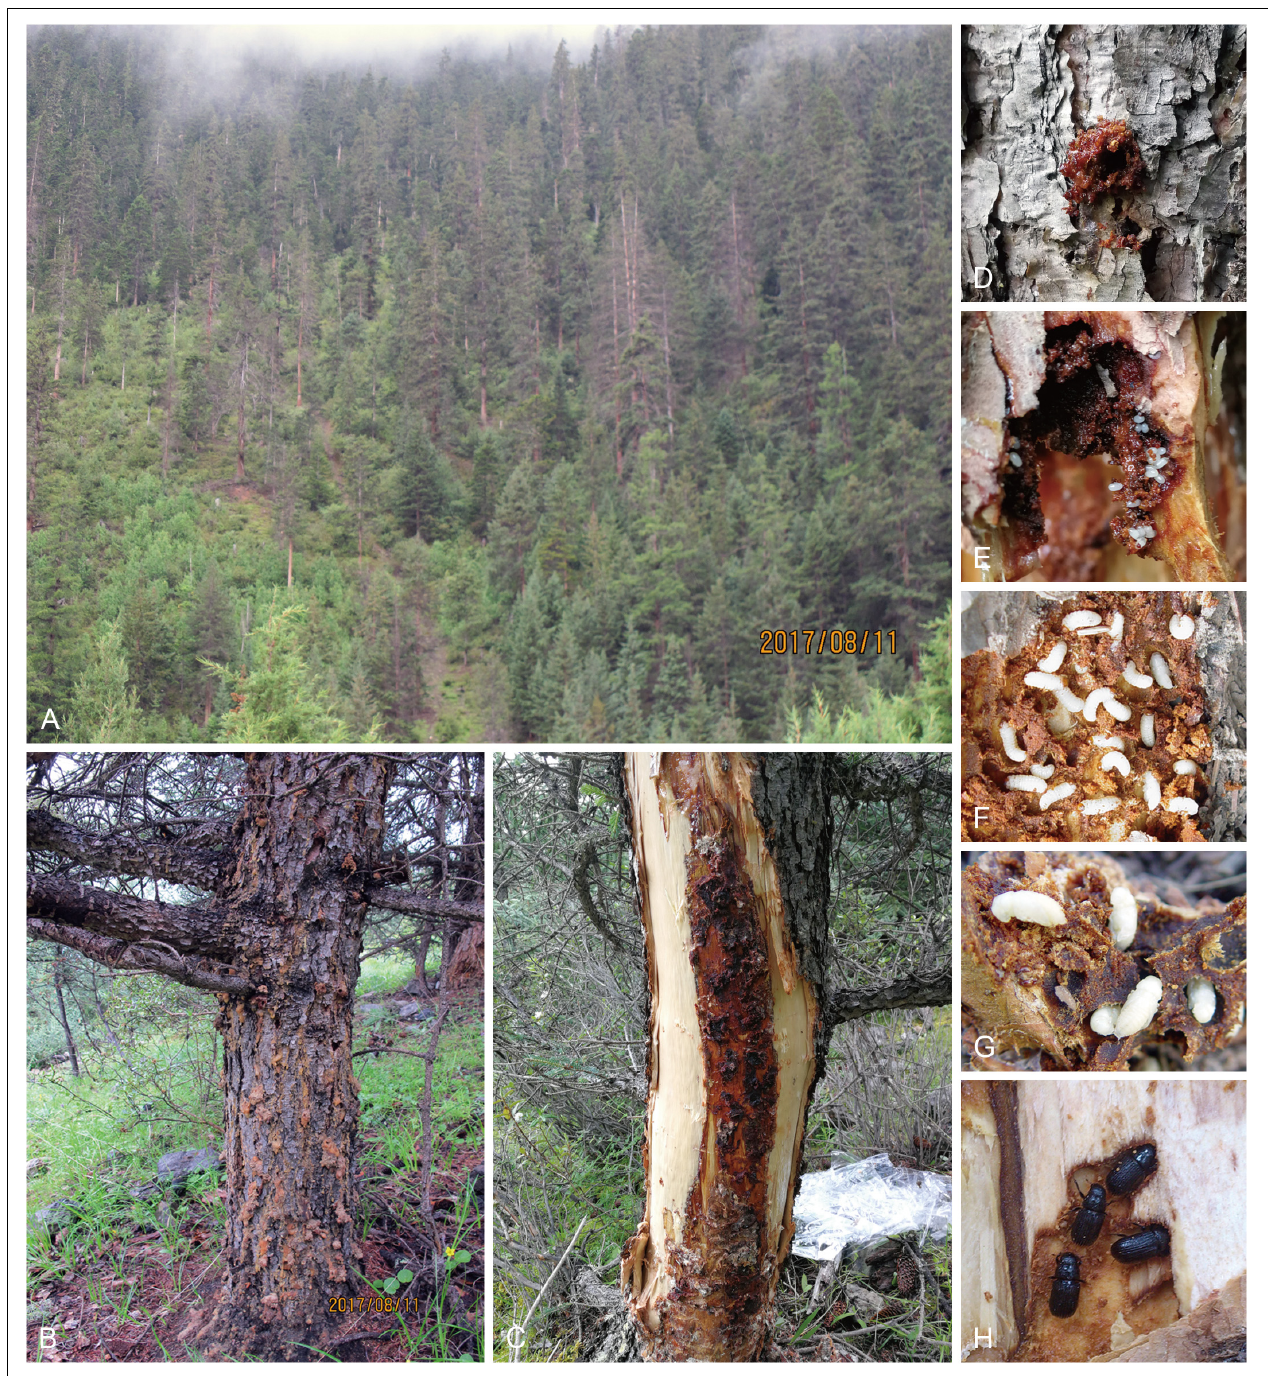
FIGURE 1 | Damage to spruce by D. micans and ophiostomatoid fungi at landscape level (A) and tree level (B,C) . Pioneer beetle invading spruce with obvious signs of reddish globules of resin tubes showing the vigorousness and active defense of the host (D) . The life cycle of the D. micans in galleries on spruce: egg (E) , larva (F) , pupa (G) , and adult (H)